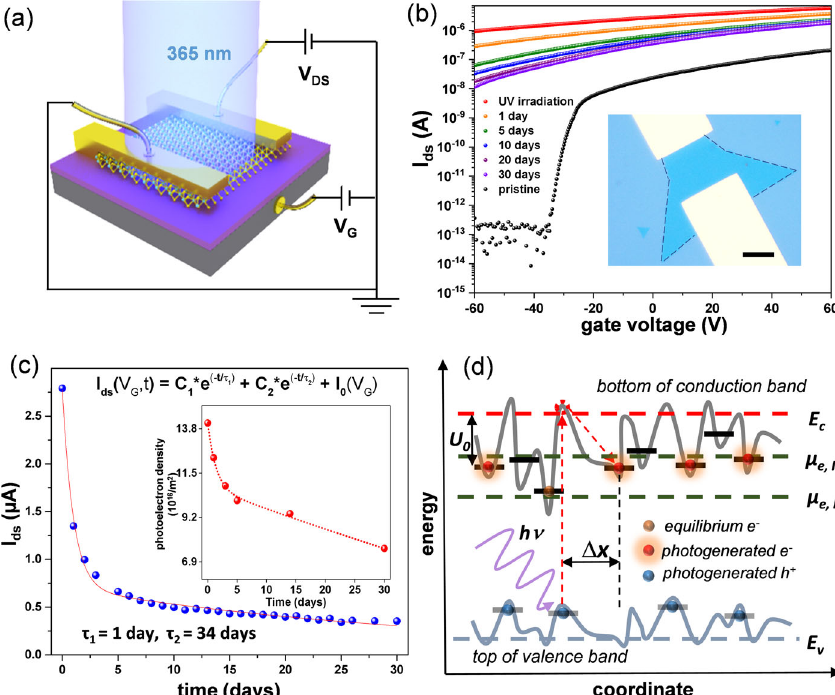
Fig. 1 Observation of GPPC effect in MoS 2 FETs. a Schematic diagram of the MoS 2 -FET device and experimental setup. b Experimental observation of GPPC in a MoS 2 -FET device. The black curve represents the transfer characteristics of the MoS 2 device before UV irradiation, the red curve represents the transfer characteristics immediately after UV irradiation ( λ = 365 nm) for 5 min with an intensity of ~30 mW cm − 2 . The colored curves represent the time-dependent transfer curves after UV irradiation. The measurements continued up to 30 days (the complete data set is provided in Supplementary Fig. 4). The inset shows an optical microscopy image of the MoS 2 -FET device (scale bar: 10 µm). c The decay of the drain current with time at V g = 0 V. The experimental data were fi tted (red curve) using a two-stage exponential decay function to extract the GPPC time constants. Calculated decay of the photoelectron concentration with time is shown in the inset. d Schematic representation of large spatial fl uctuations of the potential energy of carriers in a MoS 2 monolayer. The incident photons excite electrons from the valence band to the conduction band resulting in their spatial separation Δ x . µ e , D and µ e , I are quasi-Fermi energy levels corresponding to equilibrium electrons and photo-generated electrons,